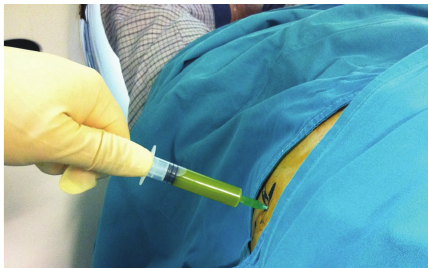
Figure 4: Bile-stained fluid drawn percutaneously.